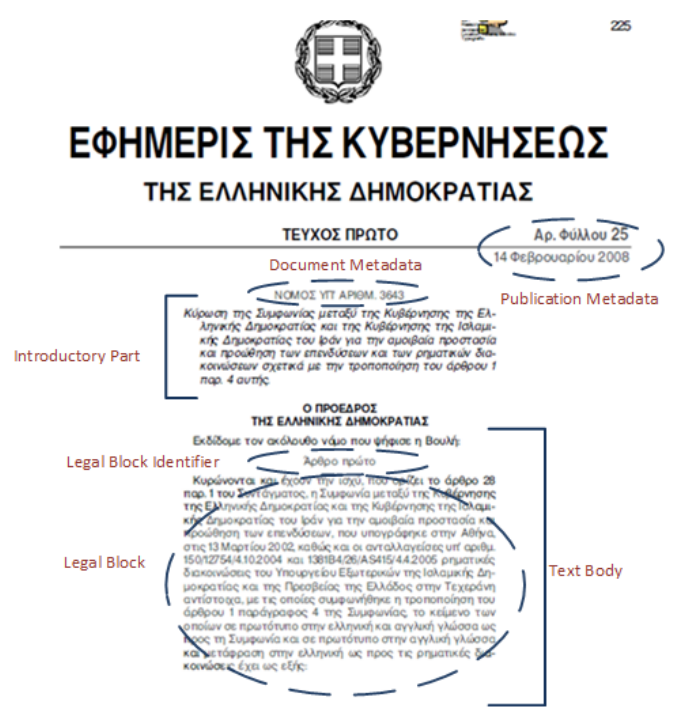
Figure 1. Overview of the structure of a legal document, with manually annotated structural parts